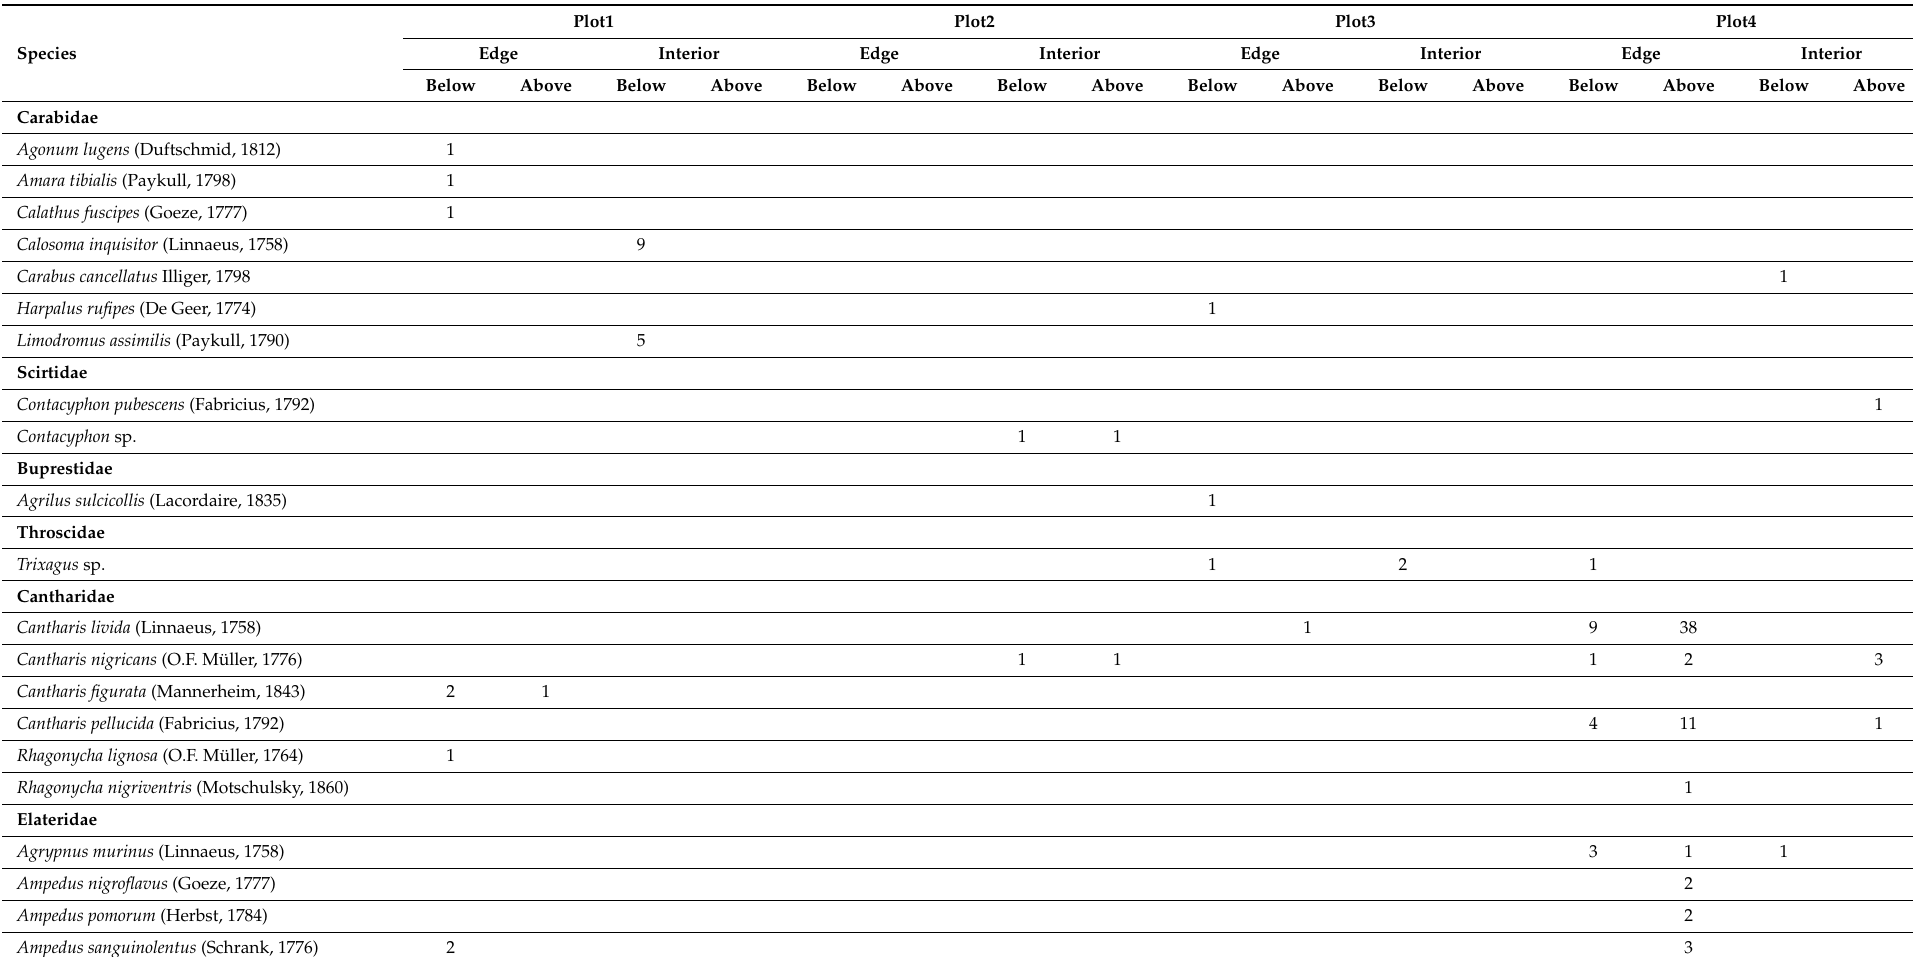
Table A1. Species diversity and absolute number of Coleoptera individuals collected using beer traps at different sites in the forests of the center of European Russia. Plot1 Plot2 Plot3 Plot4 Species Edge Interior Edge Interior Edge Interior Edge Interior Below Above Below Above Below Above Below Above Below Above Below Above Below Above Below